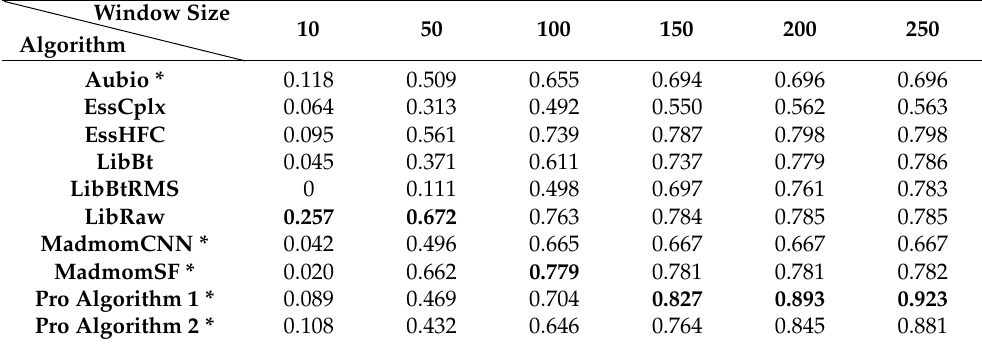
Table 2. The average of the F-measures of all the algorithms on the SVNote1 dataset based on six window sizes, from 10 to 250